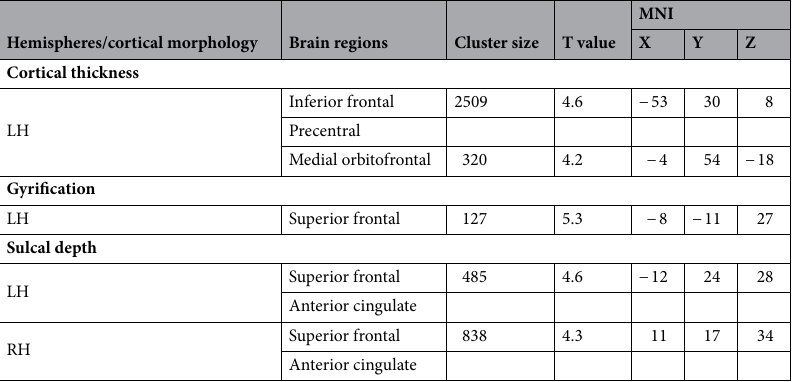
Table 2. Clusters showing significantly changed cortical morphology in the trigeminal neuralgia (TN) patients compared to the healthy controls (HC). LH (RH), left (right) hemisphere.